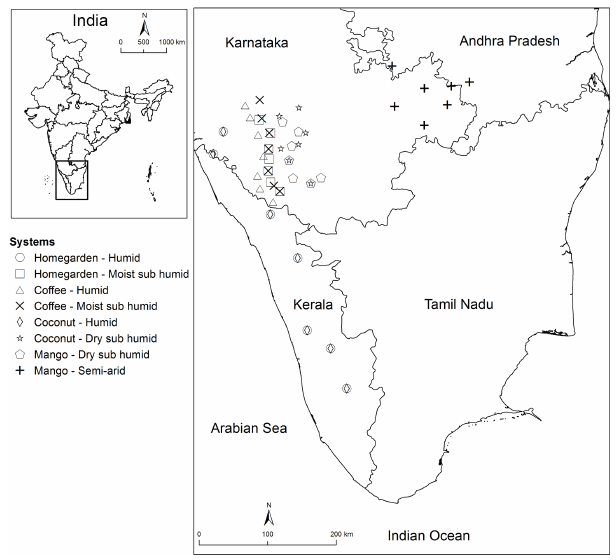
Figure 1. Geographical location of the plot clusters in southern In- dia. Each point represents a cluster of four plots: natural forest, agri- culture and the AFSs at two ages (medium and